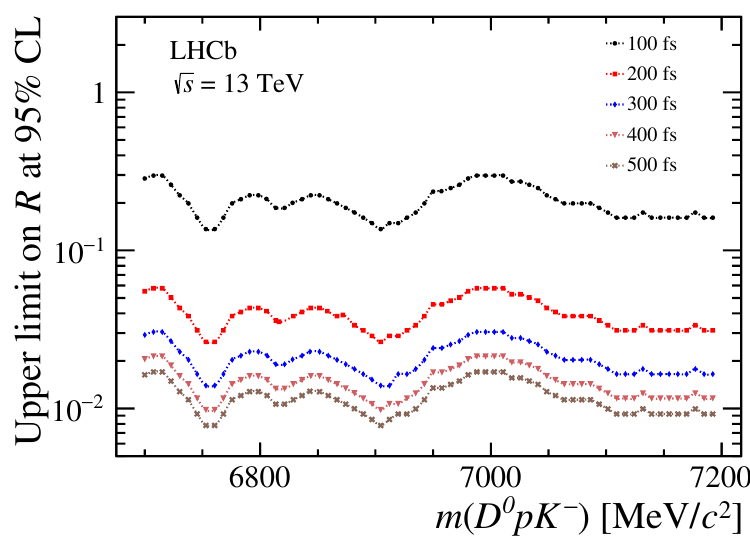
Figure 5 . Values of upper limits on R at 95% CL as a function of m ( D 0 pK (cid:0) ) for (cid:12)ve (cid:4) 0 hypotheses. The curves from top to bottom correspond to lifetime hypotheses from 100 fs to 500 fs,